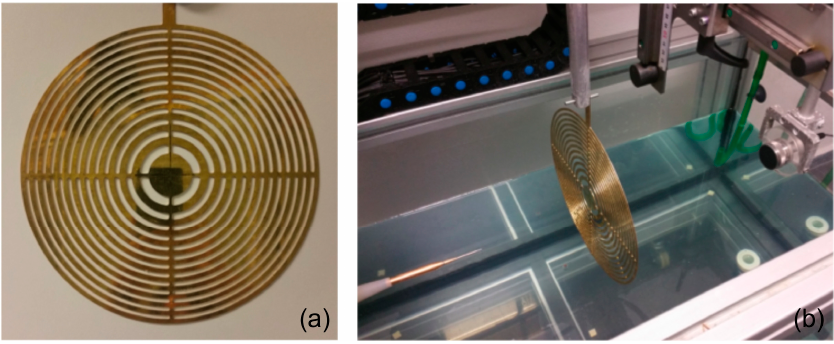
Figure 6. ( a ) Brass Soret-type FZP layout; ( b ) Experimental setup.